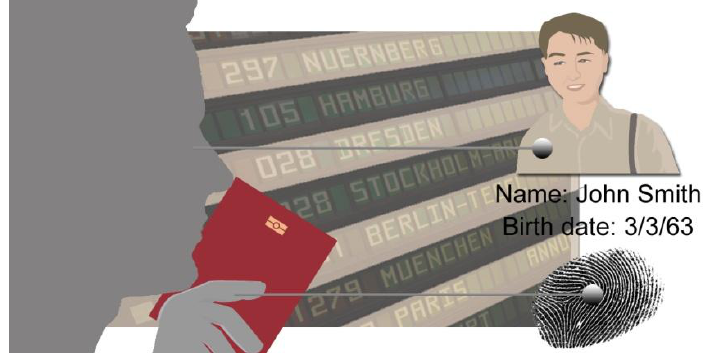
FIGURE 1. Biometrics function as anchors to the physical body of a